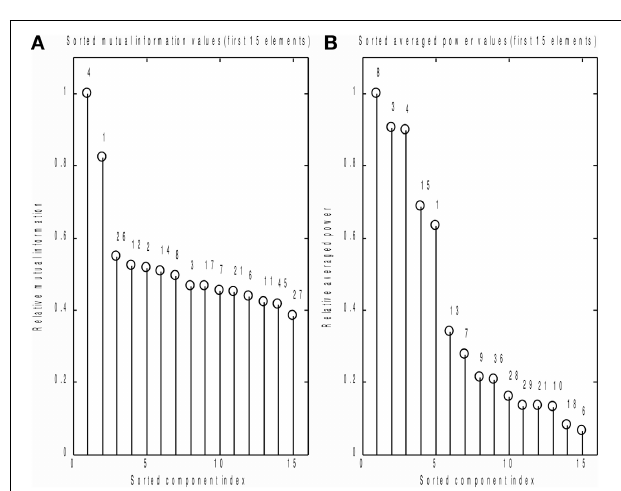
FIGURE 9 | Analysis of a subset of trials. Normalized by the first element value MI (A) and AP (B) spectra calculated using a subset of events for the first 15 independent components. On the top of each stem actual (unsorted) component number. As prescribed by the MI spectrum we should select components 4 and 1 as task related. AP spectrum suggests components 8, 3, 4, 15, 1 for this role. In order to check which of the two measures provide the right answer we inspected stimulus-locked averages of the components suggested by the two measures, see Figure 10 .